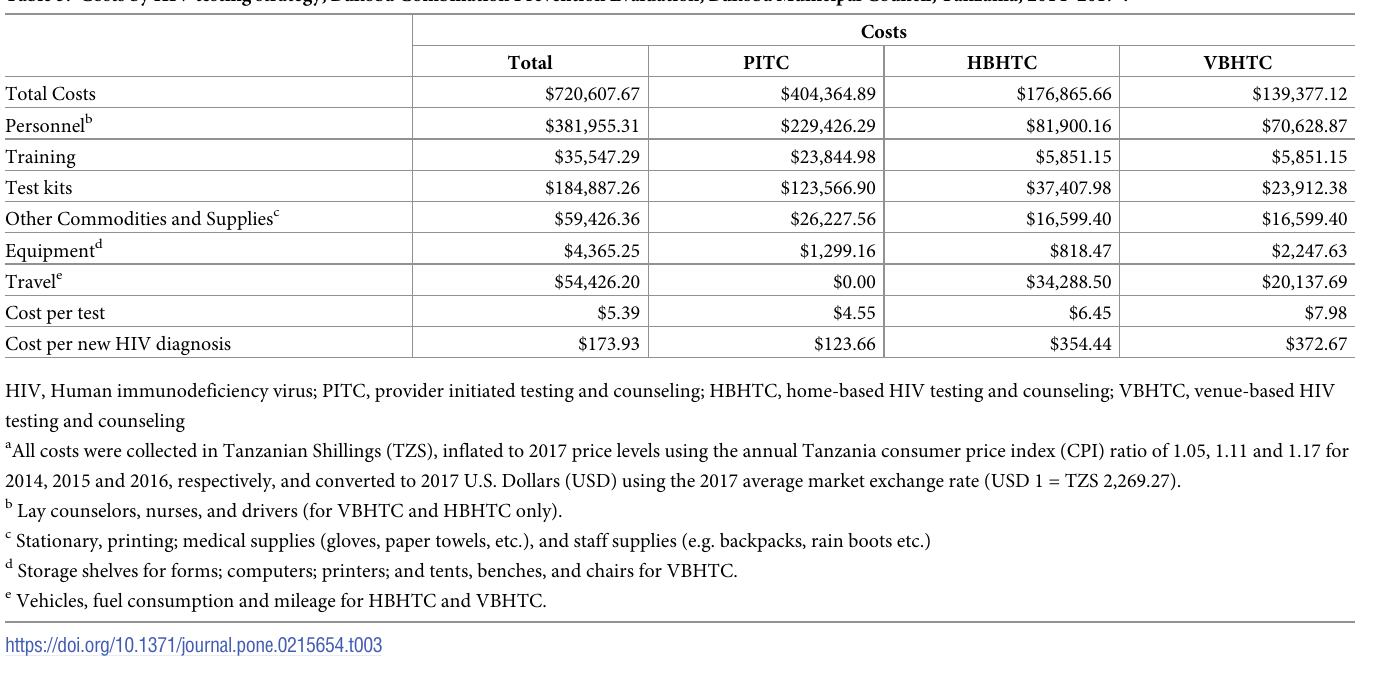
Table 3. Costs by HIV testing strategy, Bukoba Combination Prevention Evaluation, Bukoba Municipal Council, Tanzania, 2014–2017 a